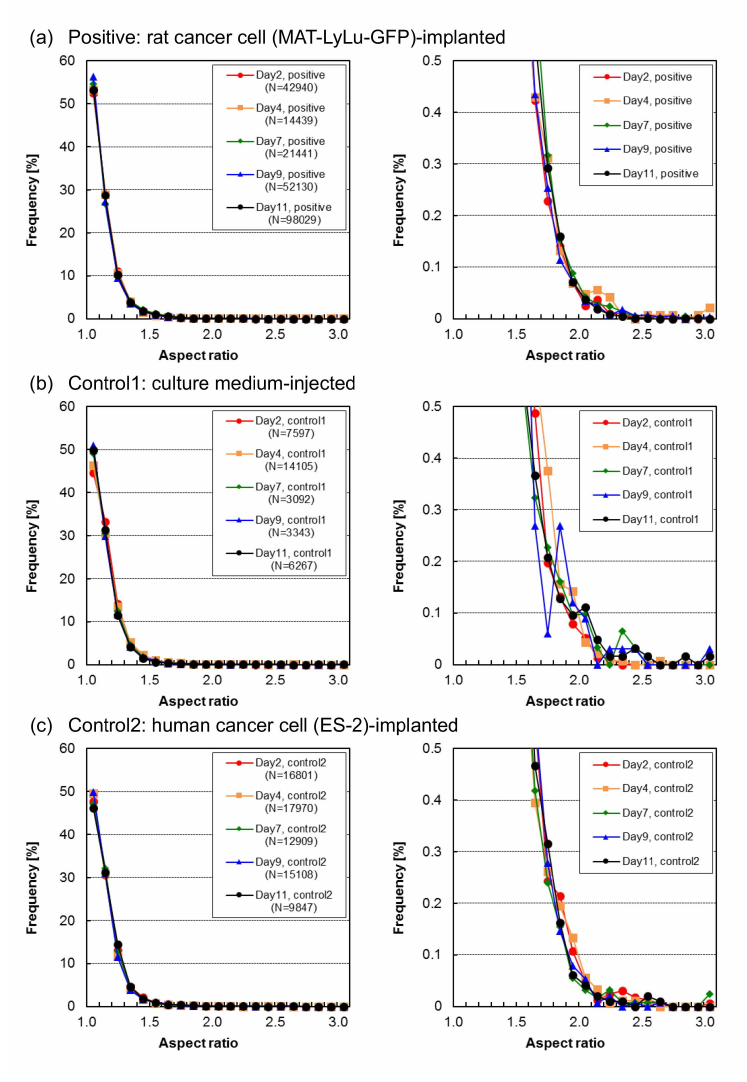
Figure 7. Aspect ratio distribution of BF cell areas in positive ( a ), control 1 ( b ), and control 2 ( c ) blood of the same samples as in Figure 4. Each size distribution map indicates 2, 4, 7, 9, or 11 days after the implantation of rat cancer cells ( a , positive), culture medium ( b , control 1), or human cancer cells ( c , control 2). Measurements were performed for six rats for positive cases and three for the two types of control. The x -axis shows 0.2 intervals, while the y -axis (frequency) value at x = 1 represents the sample population percentage having an aspect ratio of 1 to 1.2. The graphs on the right are magnified versions of those on the